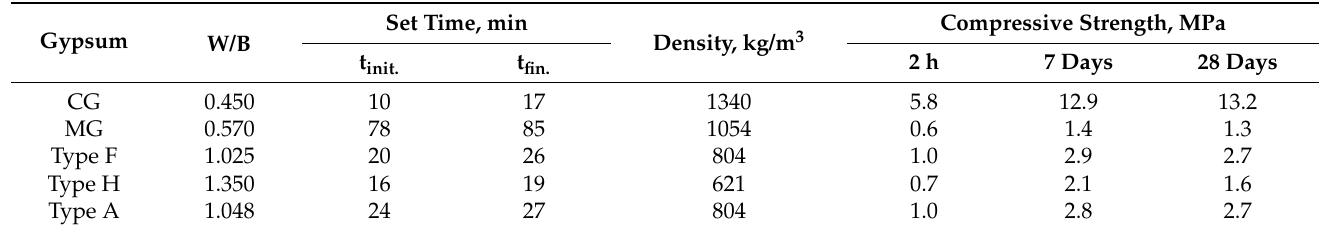
Table 4. Properties of commercial gypsum and CDW gypsum binder treated for 4 h at 130 ◦ C.